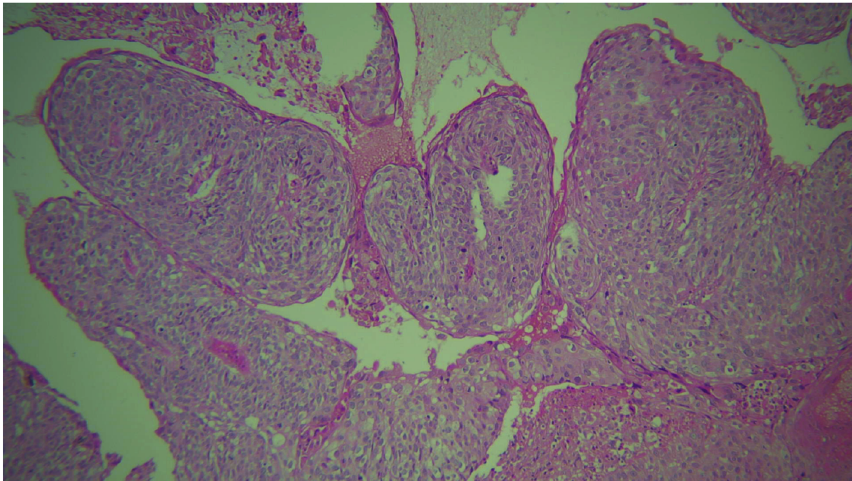
Figure 7: 4 × view: islands of basaloid cells intermixed with squamous cells.